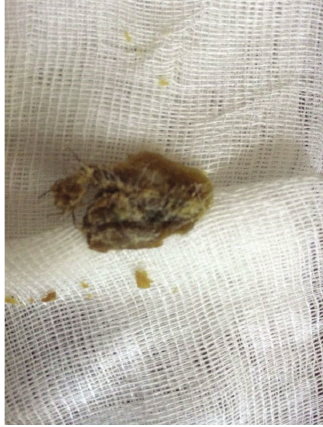
Figure 2: Lesion was excised by pedicle from vestibule.